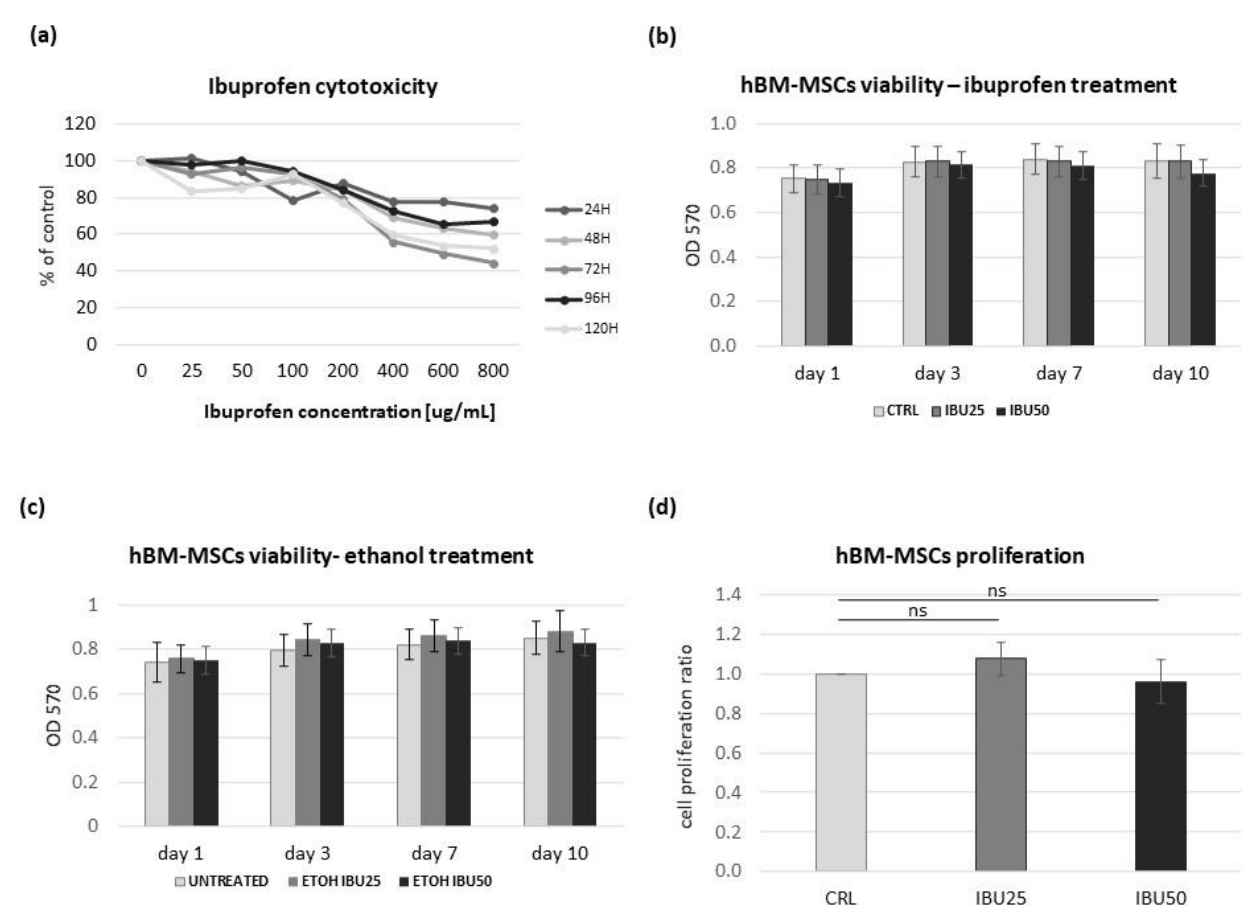
Figure 2. The effect of ibuprofen on the viability and proliferation of hBM-MSCs. ( a – c ) The effect of ibuprofen on hBM-MSCs viability was evaluated with MTT assay. ( a ) Cells from 3 donors were treated with different concentrations of ibuprofen (25 µg/mL, 50 µg/mL, 100 µg/mL, 200 µg/mL, 400 µg/mL, and 800 µg/mL) for, respectively, 24 h, 48 h, 72 h, 96 h or 120 h. The experiment was performed in triplicates. Data are presented as percentage of control cells (untreated cells analyzed after 24h); ( b , c ) The experiment was repeated for selected doses of ibuprofen (25 µg/mL and 50 µg/mL) ( c ) or adequate amount of ethanol-ibuprofen solvent ( d ) on 6 populations at 4 different time points: 1 day (24 h), 3 days (72 h), 7 days and 10 days. Diagrams present mean optical density (OD) was measured at 570 wave length. ( d ). The effect of ibuprofen on hBM-MSCs proliferation determined with BrdU assay. Bars present mean (±SEM) relative cell proliferation ratio. Samples were analyzed in quadruplicates. The experiment was performed on the cells derived from 6 independent donors. Statistical analysis was performed by the Wilcoxon matched-pairs signed-rank test in the groups of related data with abnormal distribution, and by the Student’s t -test in the groups of related data with confirmed normal distribution. p < 0.05 was assumed to be statistically significant. No statistical differences were determined between groups in the main experiment ( b – d ).